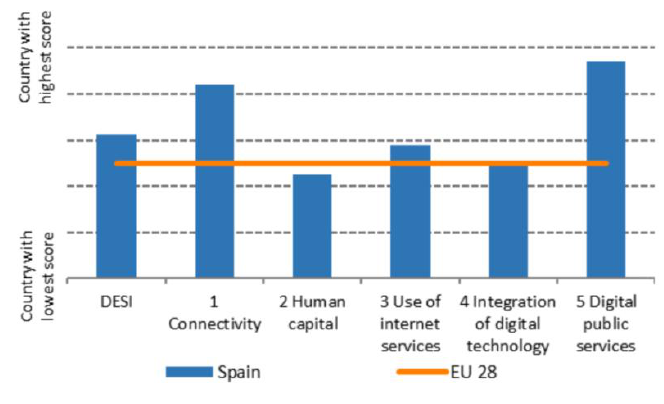
Figure 4: The Breakdown of DESI Digital Indicators 2020 (EU-28) (Source: European Commission